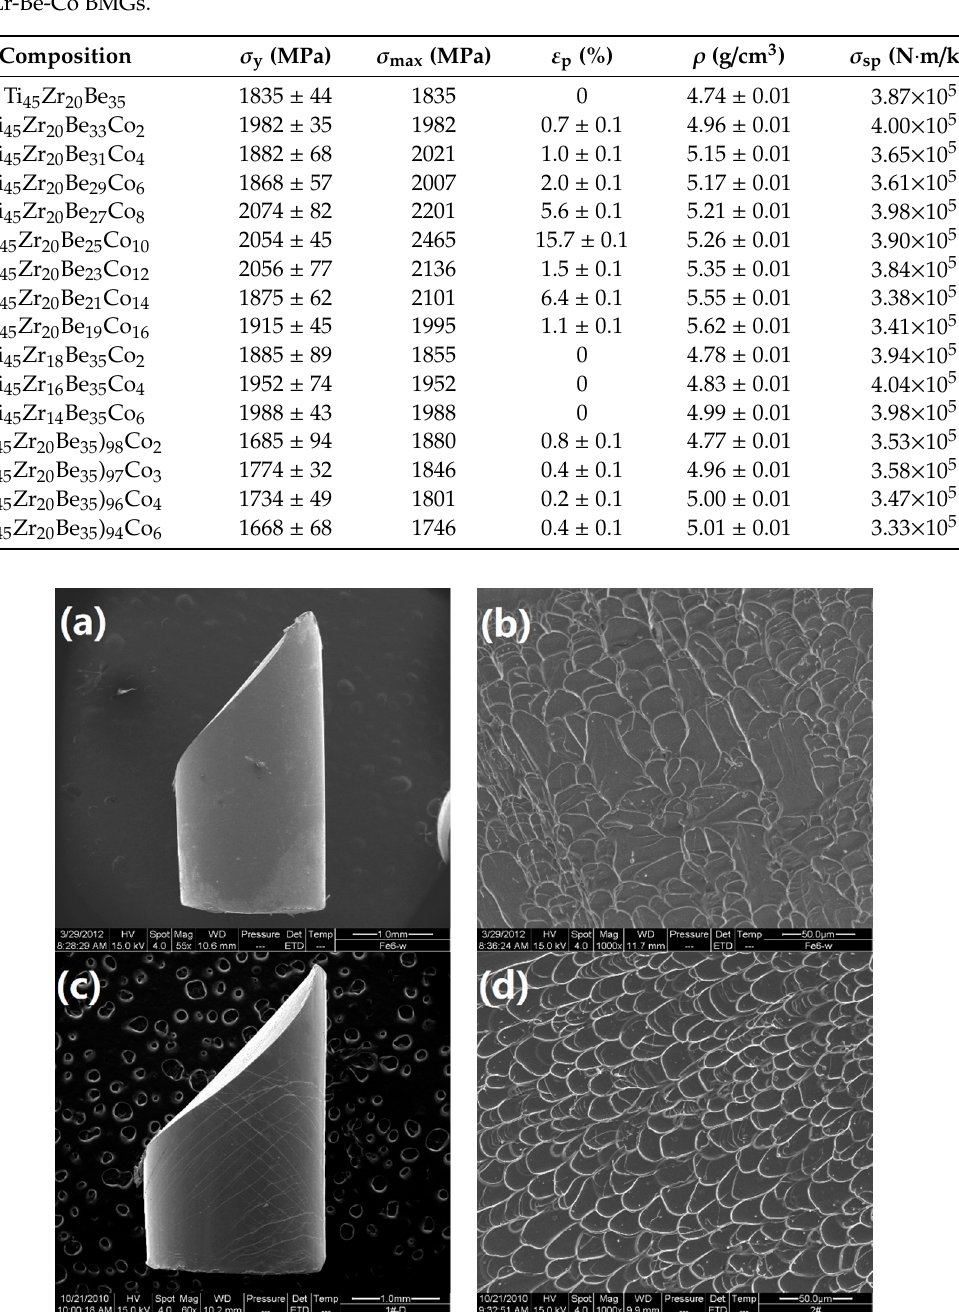
Figure 7. SEM images of fractured samples: ( a ) The lateral surface for the Ti 45 Zr 20 Be 35 alloy; ( b ) the fractured surface for the Ti 45 Zr 20 Be 35 alloy; ( c ) the lateral surface for the Ti 45 Zr 20 Be 25 Co 10 alloy; ( d ) the fractured surface for the Ti 45 Zr 20 Be 25 Co 10 alloy.